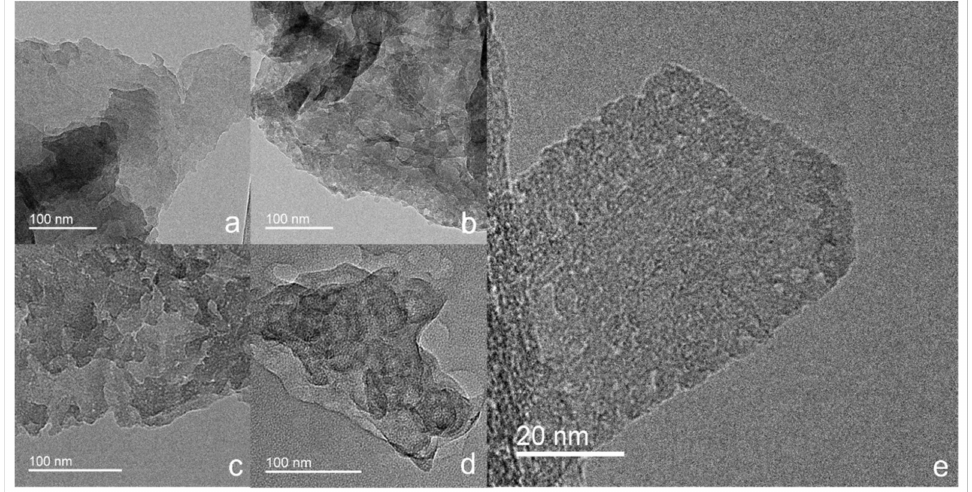
Figure 2. TEM images of CN-180-3 ( a ), CN-180-6 ( b , e ), CN-180-9 ( c ), and CN-200-6 ( d